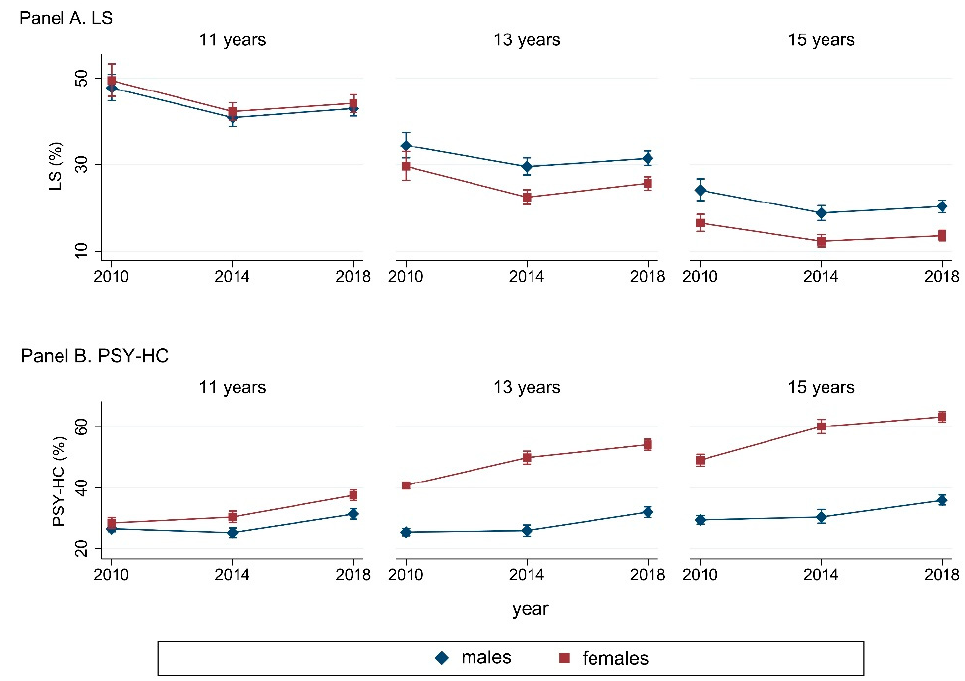
Figure 1. Prevalence (% (95%CI)) of LS ( Panel A ) and PSY-HC ( Panel B ), stratified by gender and age groups. Abbreviations: LS: life satisfaction ≥ 9; PSY-HC: ≥ 2 psychological health complaints more than once a week.